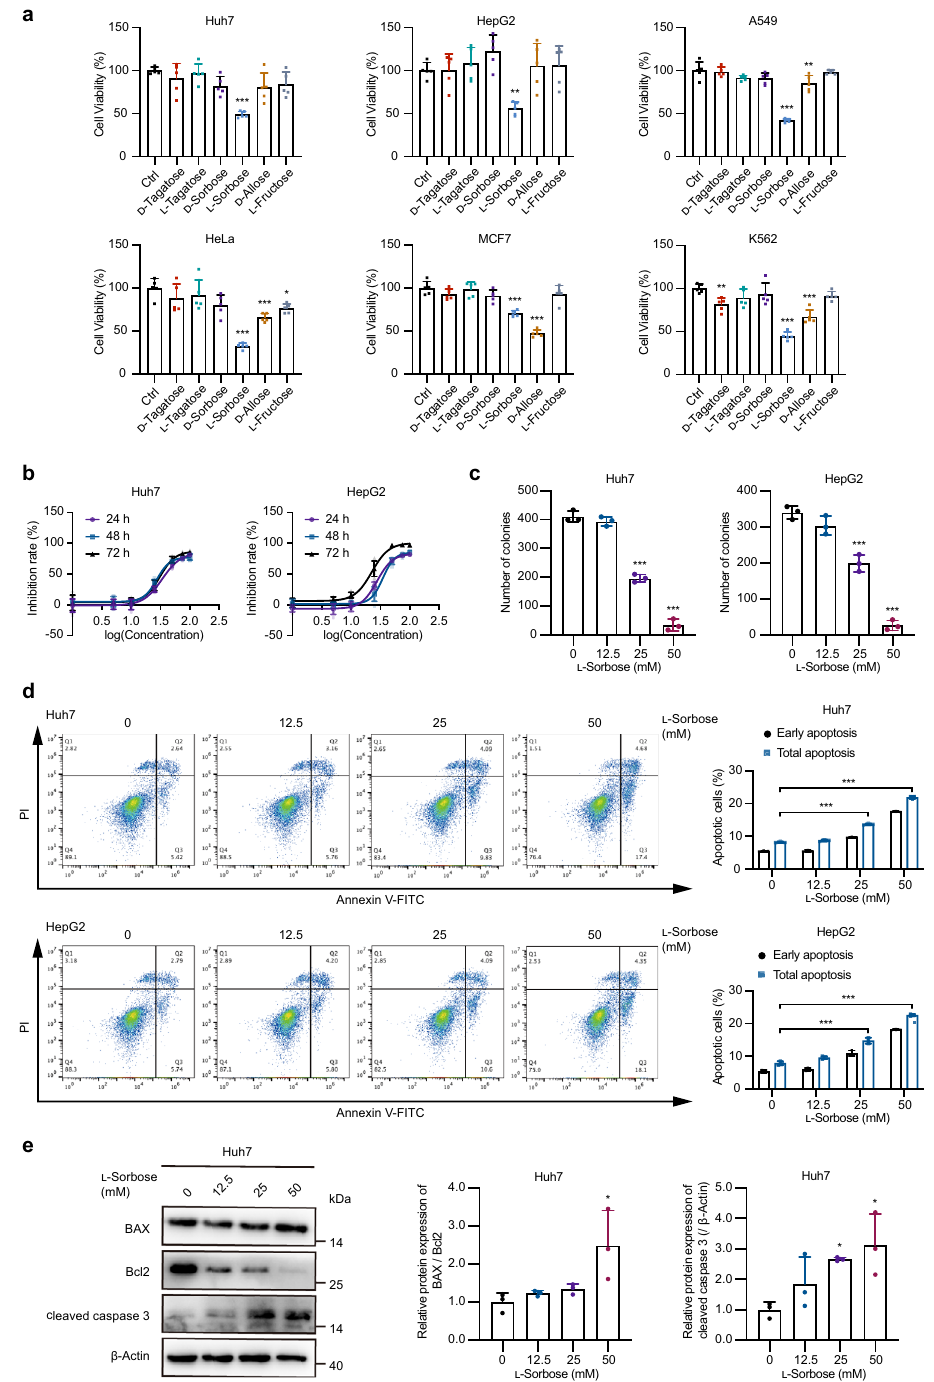
Fig. 1 L -Sorbose induces cell apoptosis. a , Cells were treated with or without (ctrl) 25 mM rare sugars for 48 h, and the viabilities were detected by CCK-8 assay. n = 5. b , Huh7 or HepG2 cells were incubated with various concentrations of L -sorbose for 24 h, 48 h and 72 h, and their viability rates were measured. n = 5. c , Cells were incubated in 0, 12.5, 25 or 50 mM L -sorbose. Long-term survival (14 days) was assayed by staining with crystal violet and the number of colonies was measured by ImageJ. n = 3. d , Cells treated with 0, 12.5, 25, or 50 mM L -sorbose for 24 h were stained with Annexin V-FITC and PI, and the ratios of apoptosis were measured by fl ow cytometry. Left panels: Representative dot plots. Right panels: Quanti fi cation of the ratio of early (annexin V-positive, PI-negative) and total (both annexin V- and PI-positive cells) apoptotic cells. n = 3. e , Left panels: Western blot showing the expression levels of BAX, Bcl2 and cleaved caspase 3 in Huh7 cells after 24 h with 0, 12.5, 25 or 50 mM L -sorbose treatment. Right panels: Quanti fi cation of the BAX/Bcl2 ratio and relative intensities of cleaved caspase 3. The BAX/Bcl2 ratio detected in Huh7 cells without L -sorbose treatment was de fi ned as 1, and the relative ratios are shown. The intensity of cleaved caspase 3 normalized to β -actin detected in cells without L -sorbose treatment was de fi ned as 1. n = 3. Data are presented as the mean ± s.d. and were analyzed by unpaired two-tailed Student ’ s t test or one-way ANOVA with Dunnett ’ s test. * P < 0.05, ** P < 0.01, *** P <